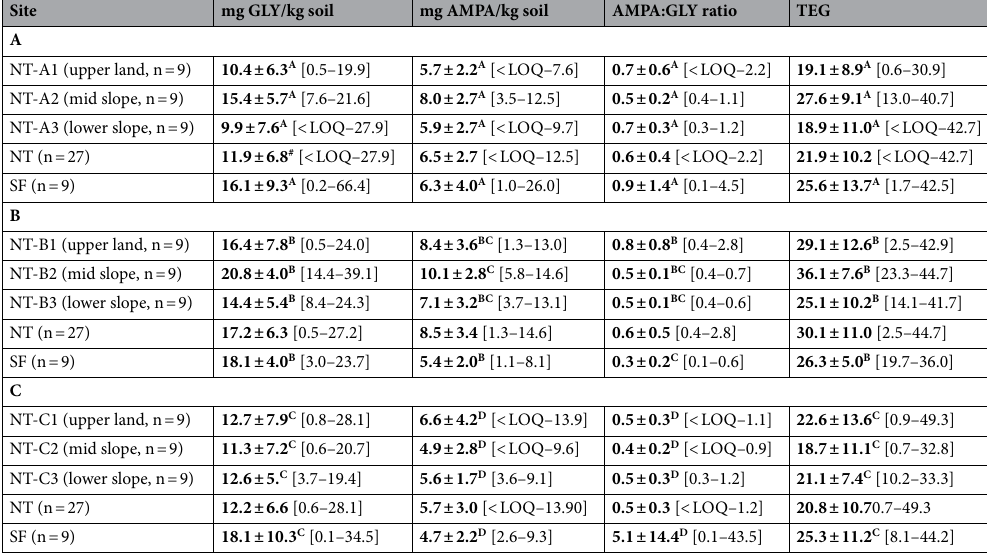
Table 2. Glyphosate (GLY) and aminomethylphosphonic acid (AMPA) concentrations, AMPA:GLY ratio and total extracted glyphosate values (TEG) in no-tillage farm (NT) and secondary Atlantic forest soils (SF) sampled in sites A, B and C. Data presents average ± standard deviation and [minimum–maximum] values. Letters represent significant differences among NT-*1, NT-*2, NT-*3 and SF-*. Significant difference were found between the different catena transects (NT-A, NT-B and NT-C, α = 0.05). No significant differences were obtained among the three SF areas (SF-A, SF-B and